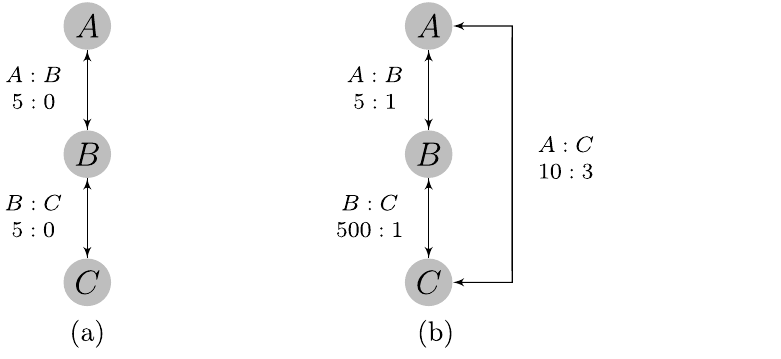
Fig. 1. Two examples in which the Bradley-Terry model fails. The Bradley-Terry estimate does not exist for the left graph despite strong evidence of a linear dominance structure. The right graph yields an unintuitive Bradley-Terry estimate for ranking the three competitors that does not seem to match the order suggested by the